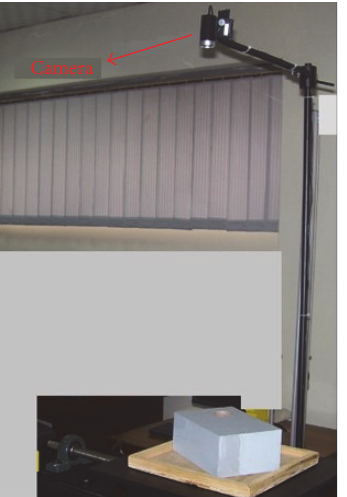
Figure 10: Camera positioning mount above pallet.